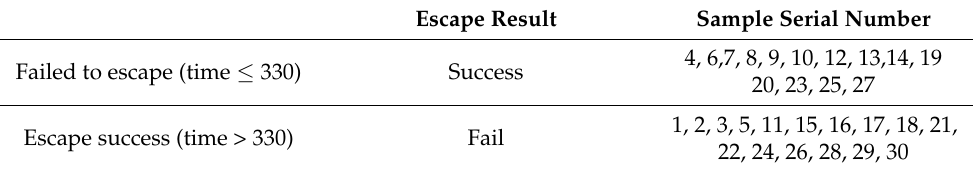
Table 7. Classification of escape results in each